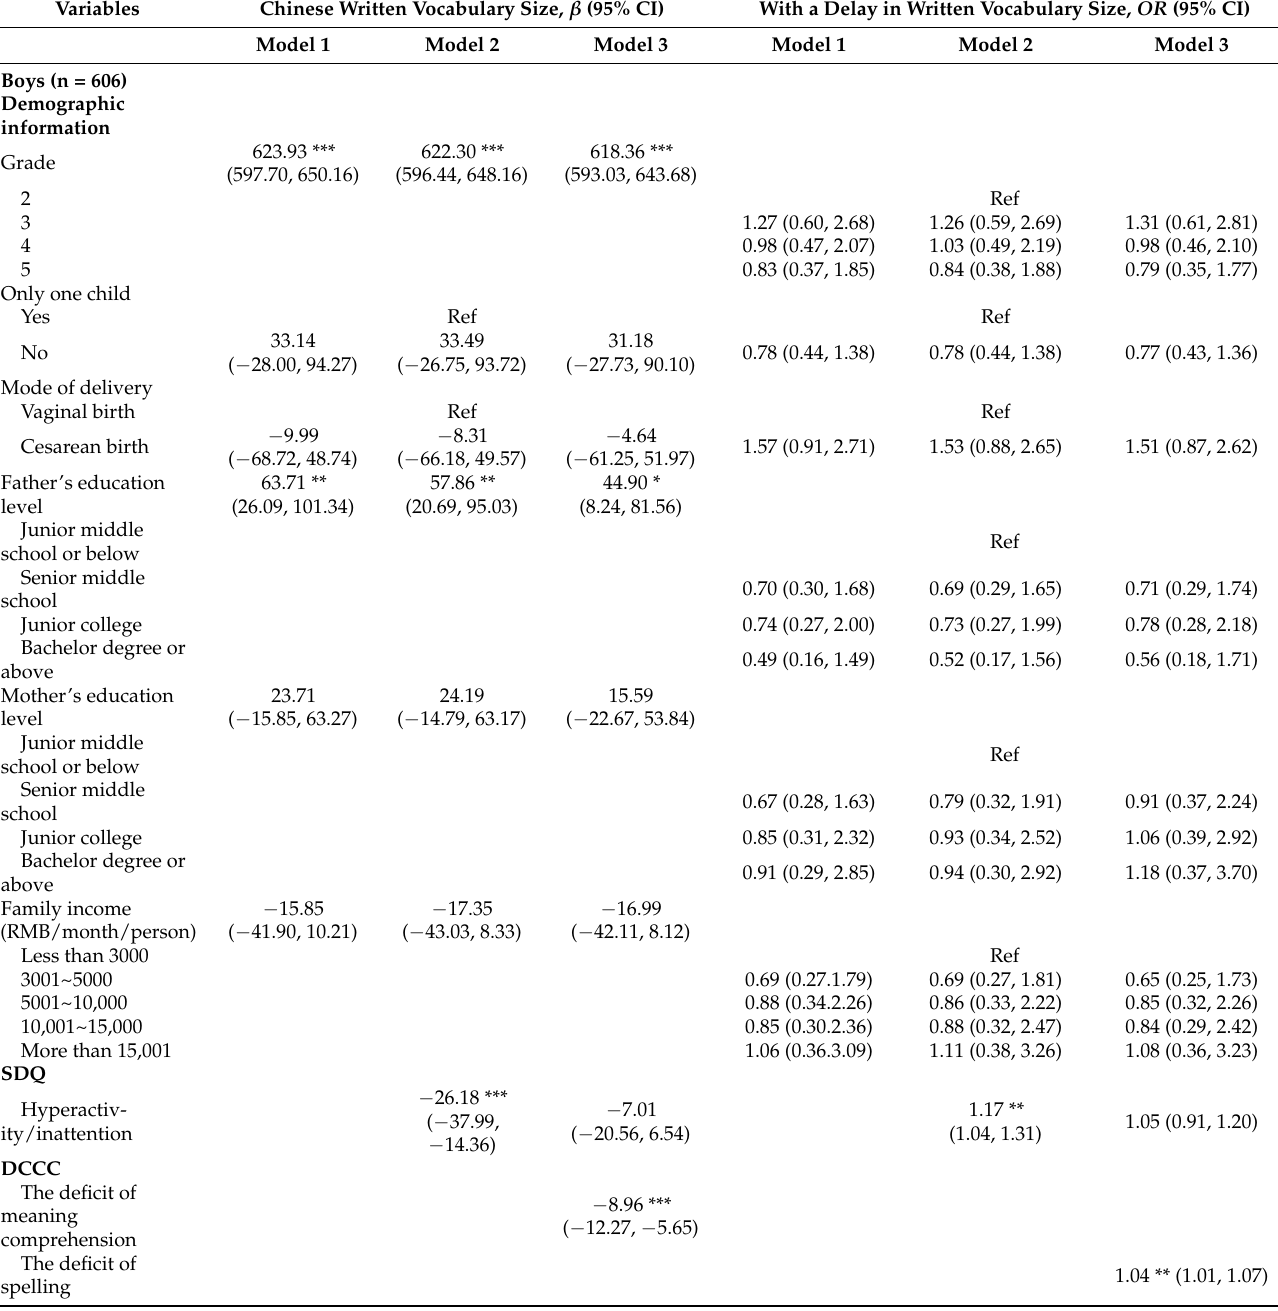
Table 4. Subgroup analysis for related factors of Chinese written vocabulary size in different gender (N =